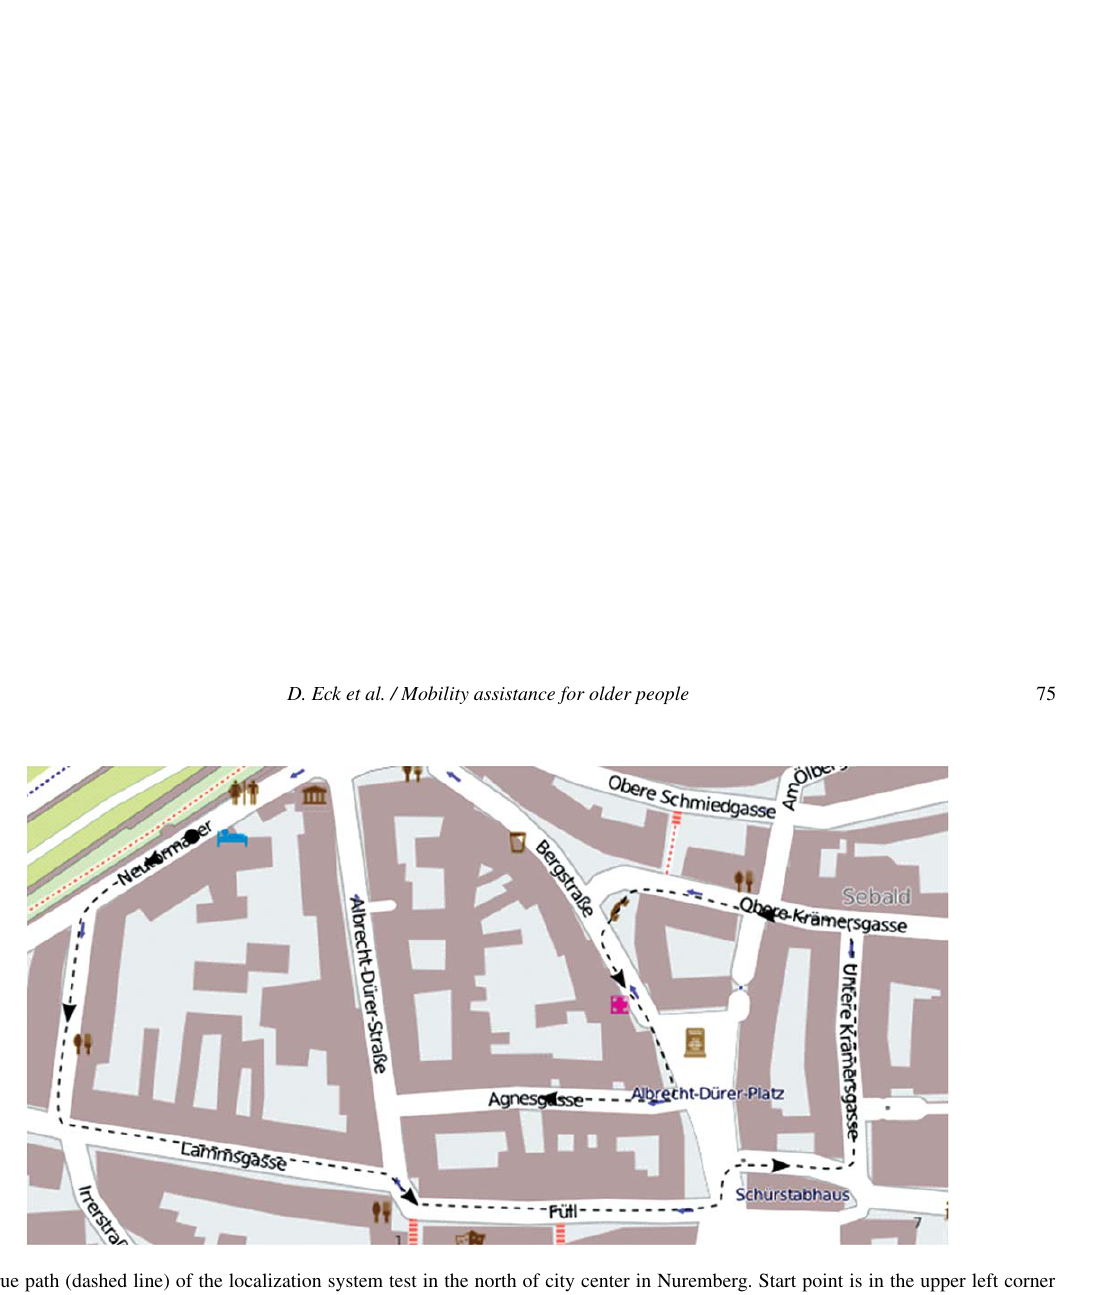
Fig. 6. True path (dashed line) of the localization system test in the north of city center in Nuremberg. Start point is in the upper left corner marked with a dot, end point in the center in “Agnesgasse” (OpenStreetMap).